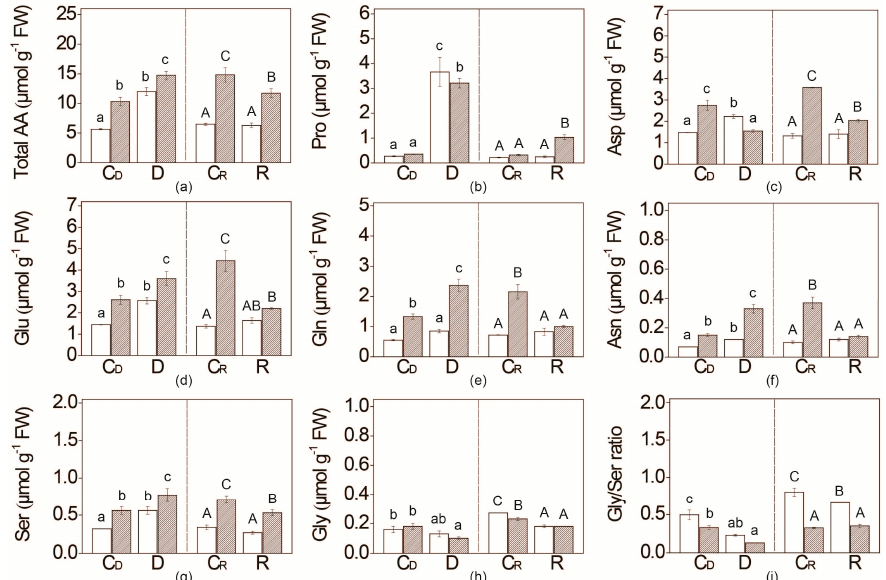
Figure 4. Content of free amino acids (AAs): ( a ) total AAs; ( b ) Proline—Pro; ( c ) aspartate—Asp; ( d ) glutamate—Glu; ( e ) glutamine—Gln; ( f ) Asparagine—Asn; ( g ) serine—Ser; ( h ) glycine—Gly; ( i ) Gly/Ser ratio; in the leaves of WT (white bars) and flacca (patterned bars) genotypes subjected to six day water deficit (D) period followed by a six day period of re-watering (R). Respective controls corresponding to water deficit condition (C D ) and re-watering (C R ) are presented. Values are presented as means ±SE ( n = 4). Different letters denote significant differences between means according to Tukey HSD post hoc test p ≤ 0.05. Small letters represent the differences in means of drought treatment, while capital letters represent re-watering treatment.